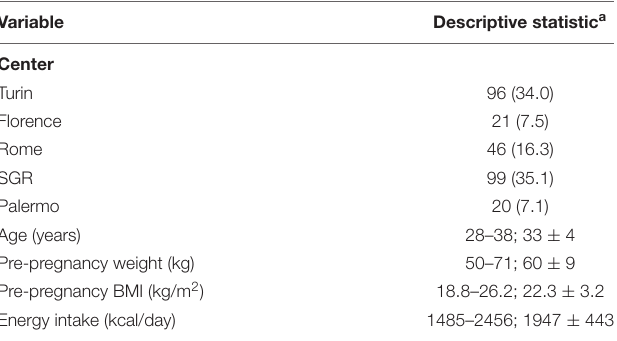
TABLE 1 | Distribution of 282 Italian breastfeeding mothers according to center, age, pre-pregnancy weight and BMI, and energy